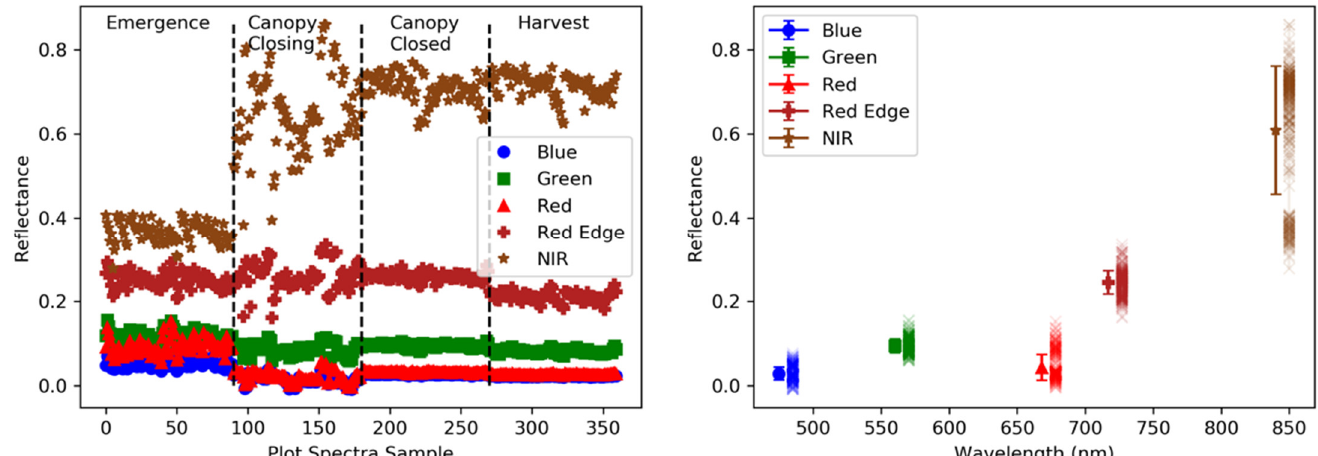
Figure 3. ( Left ) Median blue, green, red, red edge, and near-infrared reflectance of each plot’s canopy pixels (background soil masked out) from table beet plots in New York in 2018. The vertical dashed lines separate the data in terms of the growth epochs observed in the 2018 season. ( Right ) The average and standard deviation of all individual plot median reflectance measurements are shown alongside the range of the individual measurements (X’s).